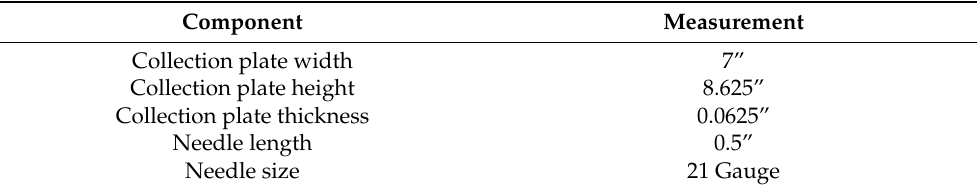
Table 1. Electrospinning setup measurements.